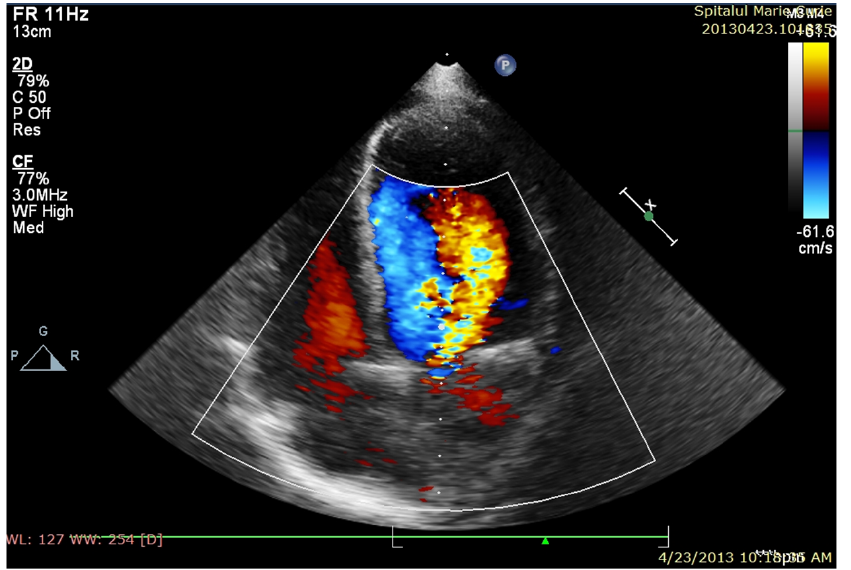
Figure 2. TTE: A5CH (modi fi ed): severe aortic regurgitation. Echocardiography performed at discharge evidenced slowly improving kinetics in both ventricles, with LVEF = 35% and LVEF = 45% at discharge (Figure 2). One year after surgery, our patient had a good cardiovascular status with good exercise tolerance and controlled BP on Furosemide and Captopril medication; muscle enzymes were still elevated after surgery (CK = 5156 UI/L, CKMB = 154 UI/L, ALT = 242 UI/L, AST = 147 UI/L, LDH = 649 UI/L), and the athletic de fi cit was aggravated progressively. dysfunction, with EF = 40%, minor regurgitation of neoaorta, good functionality of pulmonary homograft, mild mitral stenosis and a large residual coarctation (Figure 3).